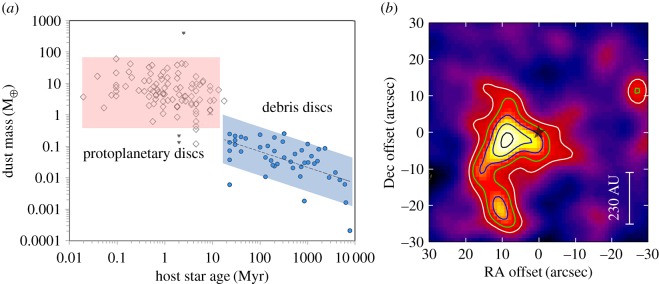
(a) The derived dust mass as a function of host star age, for both protoplanetary and debris discs (the latter exclusively from the SONS survey). (b) The SONS 850 μm image of the debris disc surrounding the nearby Sun-like star HD 38858. The dust mass figure was adapted from Matthews & Kavelaars [135] and includes the results from the SONS survey. The HD 38858 figure is adapted from Holland et al. [136].